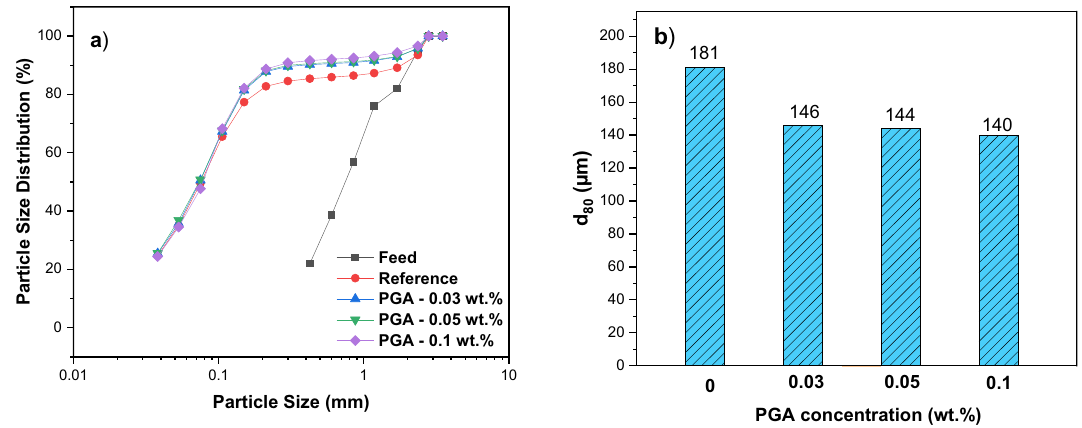
Figure 4. The particle size distribution and d80 of grinding products with and without